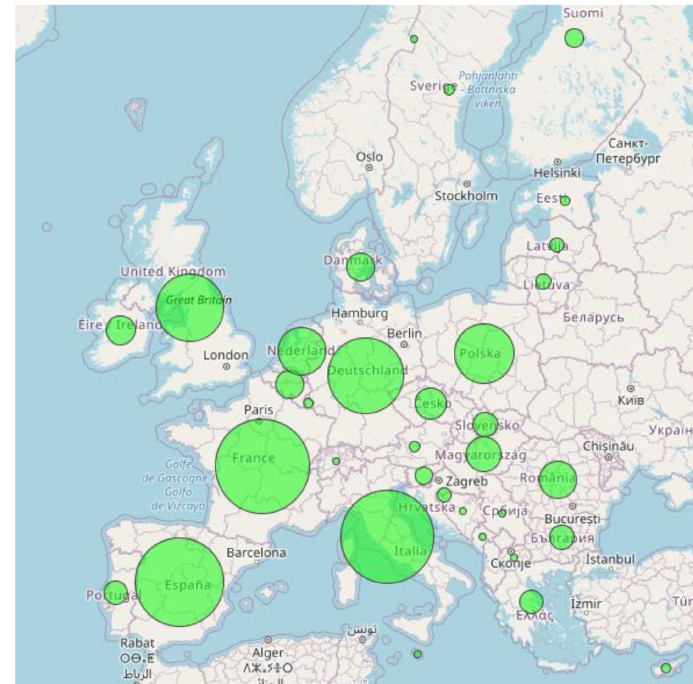
Figure 4. 600 TWh biomethane supply breakdown in the sensitivity scenario (EU27+UK).